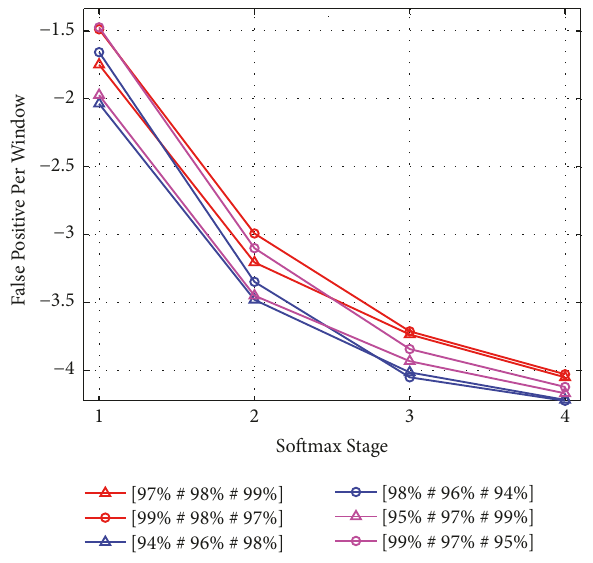
Figure 7: FPPW for cascade with different settings.